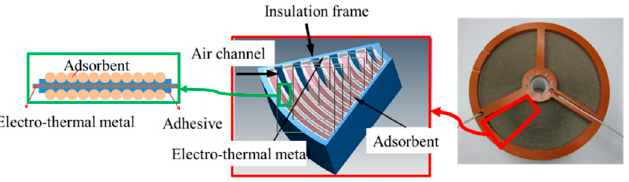
Figure 2. Structure of the main components in the proposed direct electrothermal regeneration